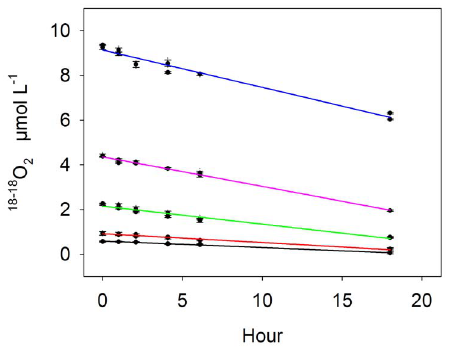
Figure 6. Experiment 3: Time series of 18-18 O 2 concentrations in Exetainers. The O 2 consumption in 5 incubations with different initial 18-18 O 2 concentrations was measured. For each Exetainer, individual MIMS measurements are averaged (black dots) and presented with the respective standard deviation.